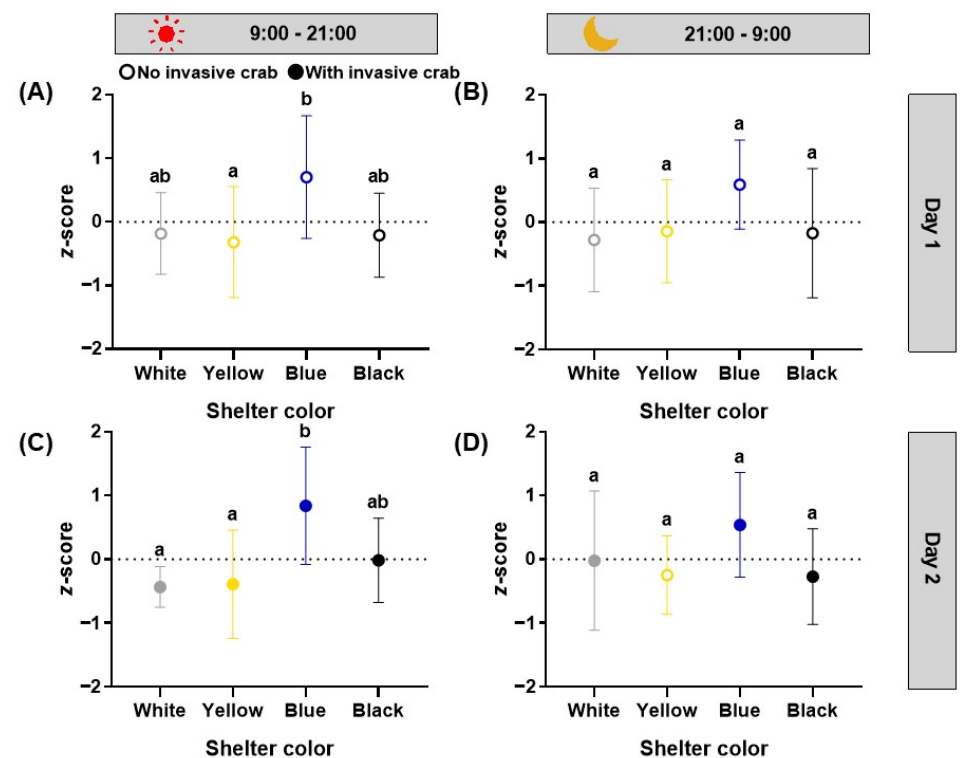
Figure 4. Mean z -scores for the counts of occupation of different colored shelters: the daytime of Day 1 ( A ), the nighttime of Day 1 ( B ), the daytime of Day 2 ( C ), and the nighttime of Day 2 ( D ). Different lowercase letters represent statistically significant differences among z -scores ( p < 0.05).